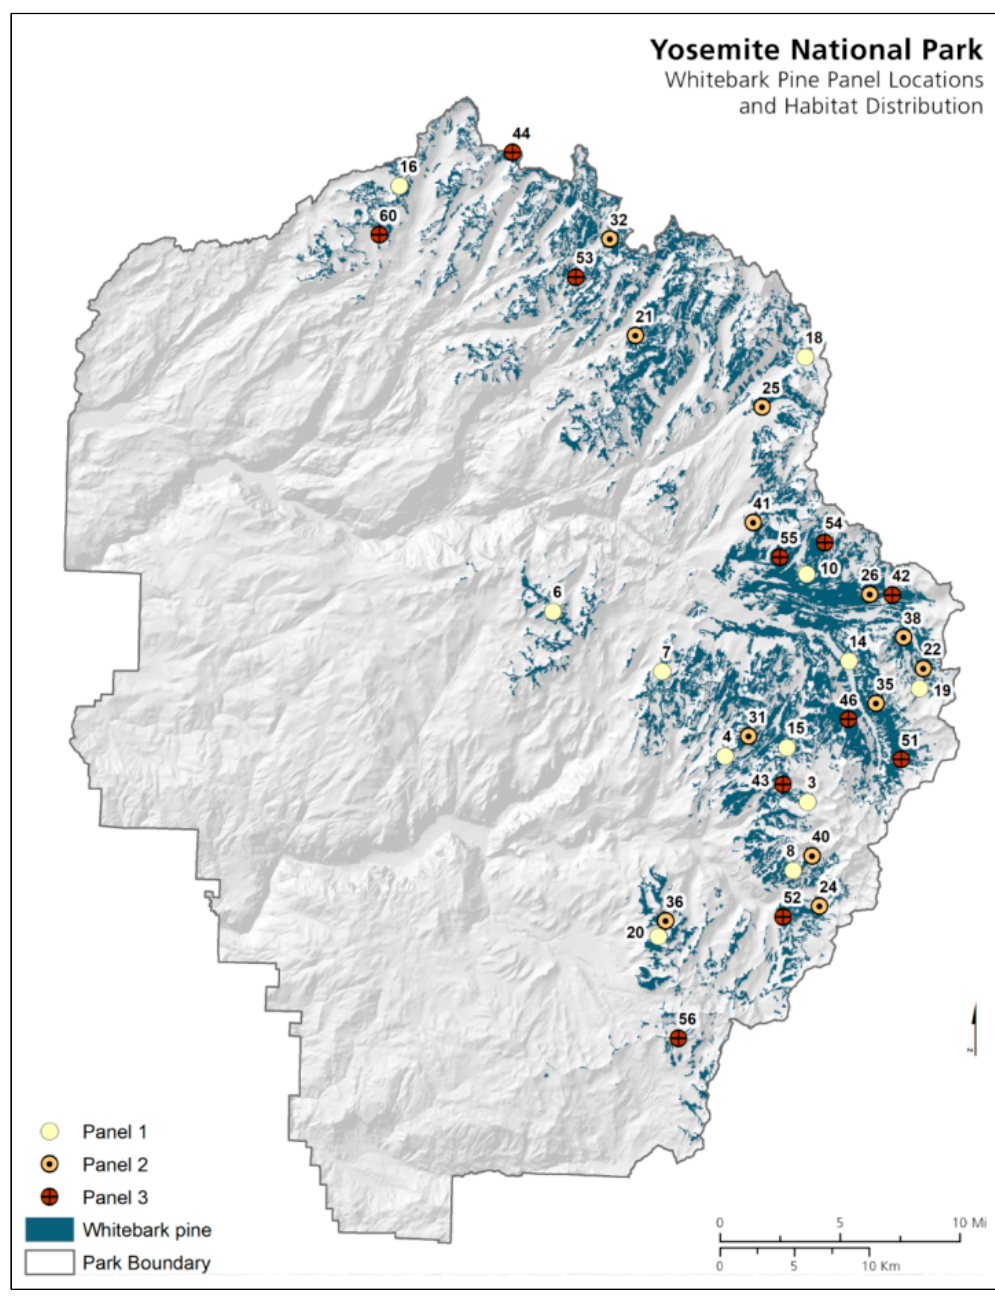
Figure 4. Whitebark pine distribution and plot locations in Yosemite National Park, CA, USA. Plots are assigned to one of three panels (12 plots each) and are sampled using a rotating re-visit design. Thirty-five of the planned 36 plots had been installed at time of